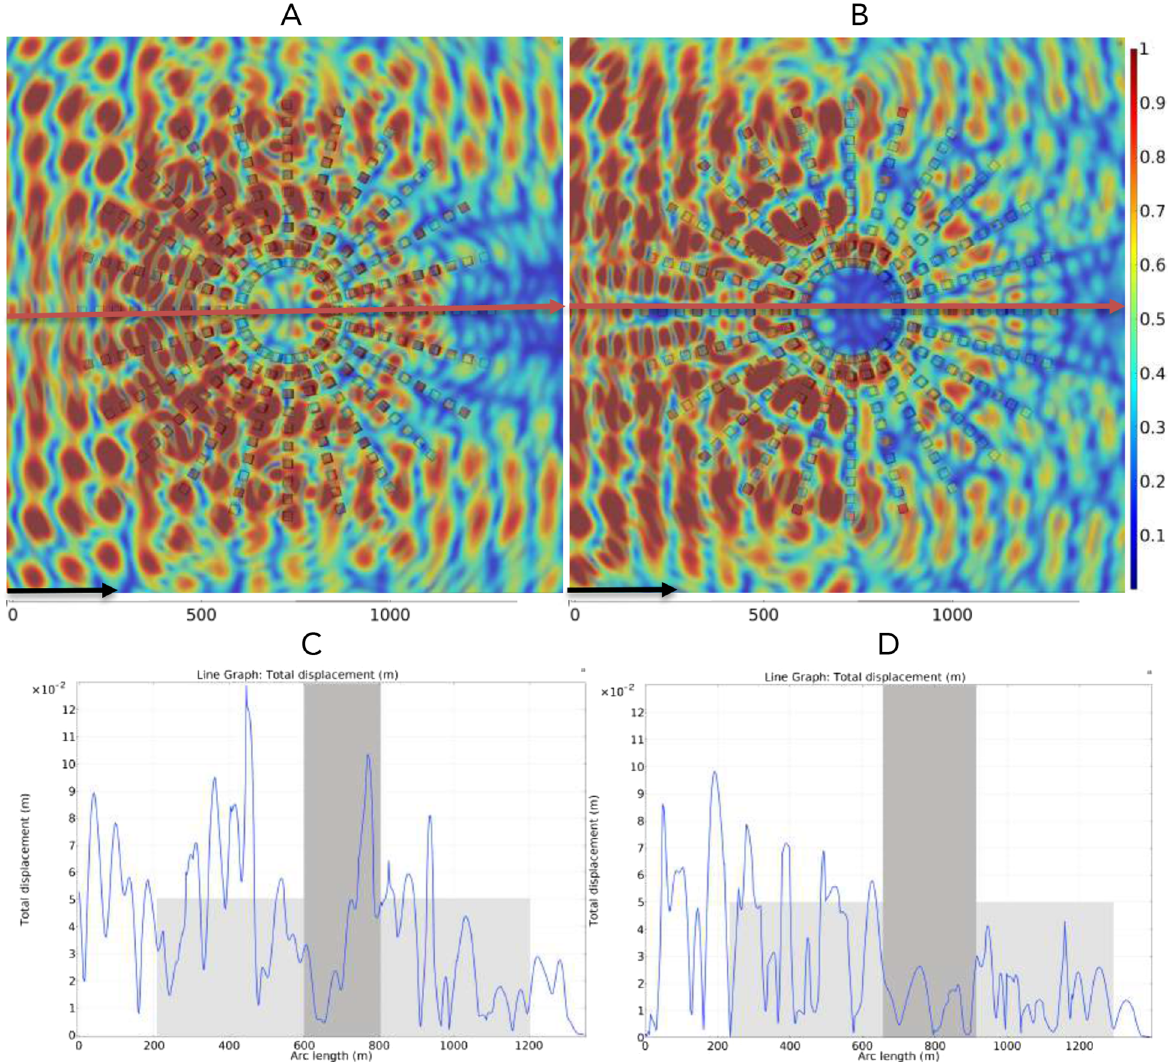
Fig. 6. Scattering of the metacity cloak by a plane wave source at 20Hz; (A), (C) concrete buildings on a concrete plate ( E =25e9 [Pa], r =2300 [kg/m 3 ], n =0.2); (B), (D) steel buildings ( E =200e9 [Pa], r =7870 [kg/m 3 ], n =0.29) on a concrete plate. Color scale is as in Figure